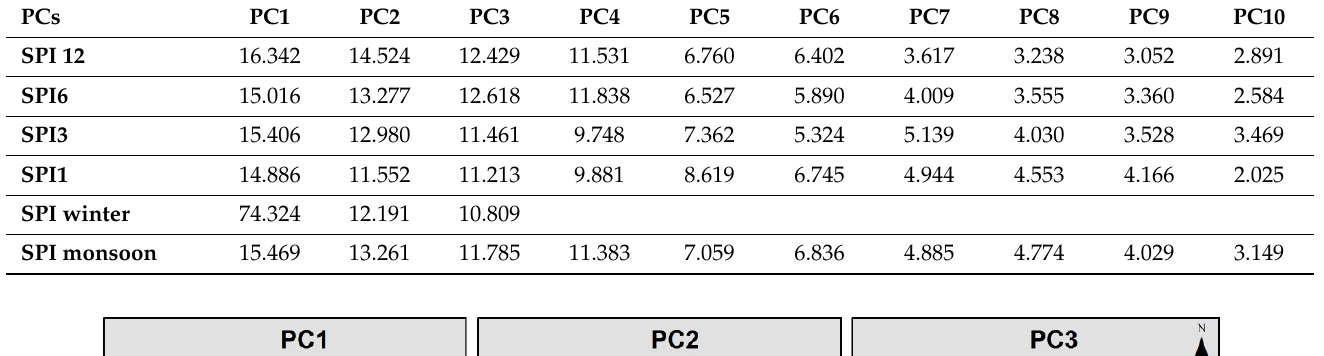
Table 3. Percentage of variance explained by loadings with varimax rotation.